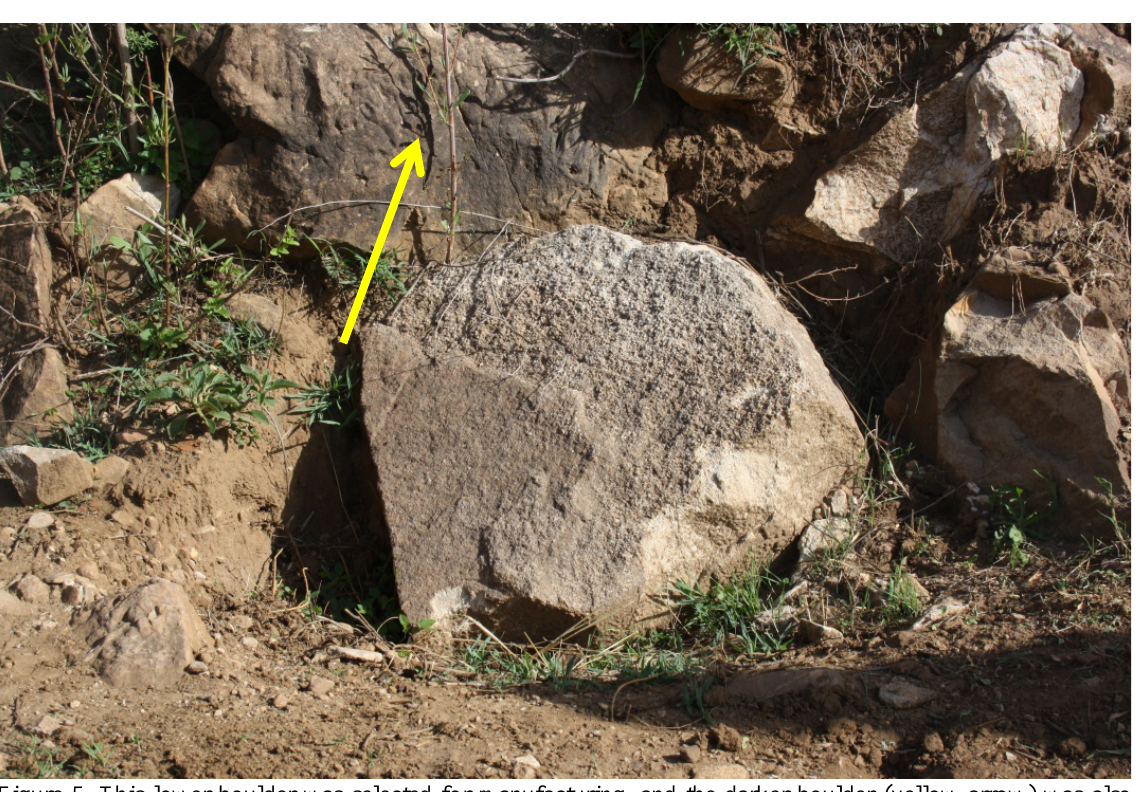
Figure 5. This lower boulder was selected for manufacturing, and the darker boulder (yellow arrow) was also excavated to enable access to lower